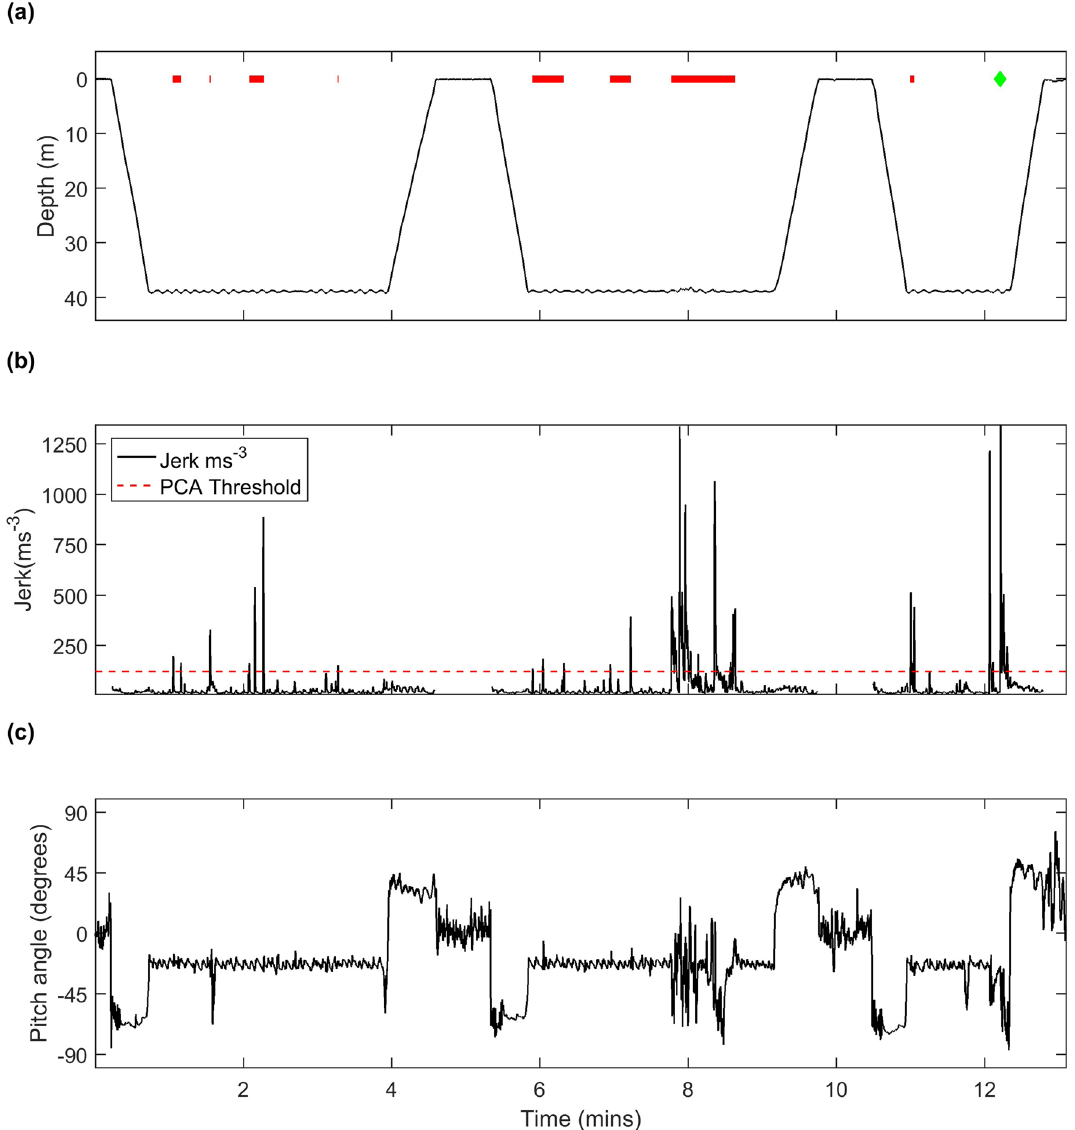
Figure 3. ( a ) Sequence of foraging dives from hs16_265a trip 1 showing the duration of detected prey capture events (PCAs) as red horizontal lines. The green diamond indicates a potential large prey capture (HVP) due to the jerk transient occurring near the end of an atypically short dive suggesting handling at the surface. ( b ) Root mean square of the norm jerk (200 Hz sampling rate, 0.4 s averaging time) over the same interval from which prey captures were inferred. The PCA detection threshold is indicated by the red dashed line. A blanking time of 20 s between PCA detections means that multiple jerks separated by less than this interval are interpreted as a single PCA, represented by individual horizontal red lines in ( a ). Gaps in jerk indicate where the signal has been blanked to prevent false PCA detections when the animal is at the surface. ( c ) Pitch angle of the animal over the same time interval. A negative pitch angle indicates a head-down posture and when this occurs at the base of dives benthic prey are likely being